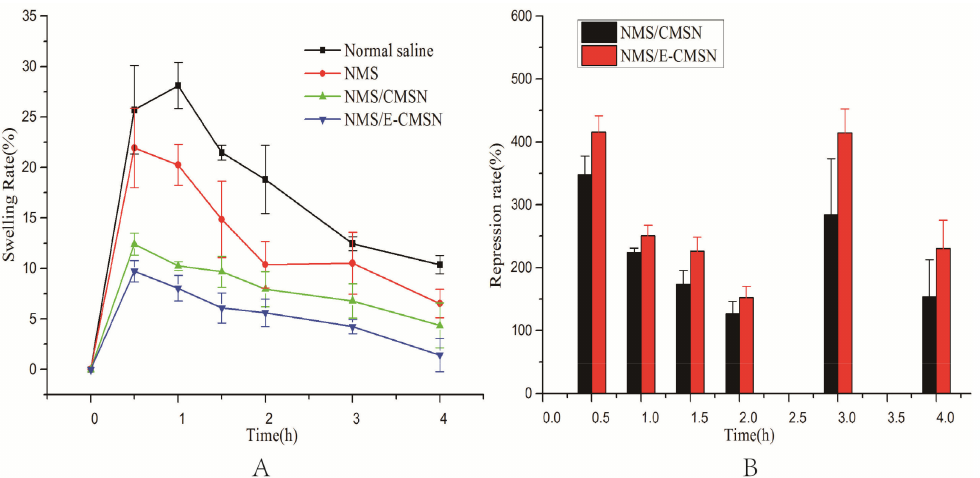
Figure 9. ( A ), the e ff ects of NMS, NMS / CMSN, NMS / E-CMSN on mouse ankle swelling rate; ( B ), the anti-inflammatory repression rate of NMS / CMSN and NMS / E-CMSN.